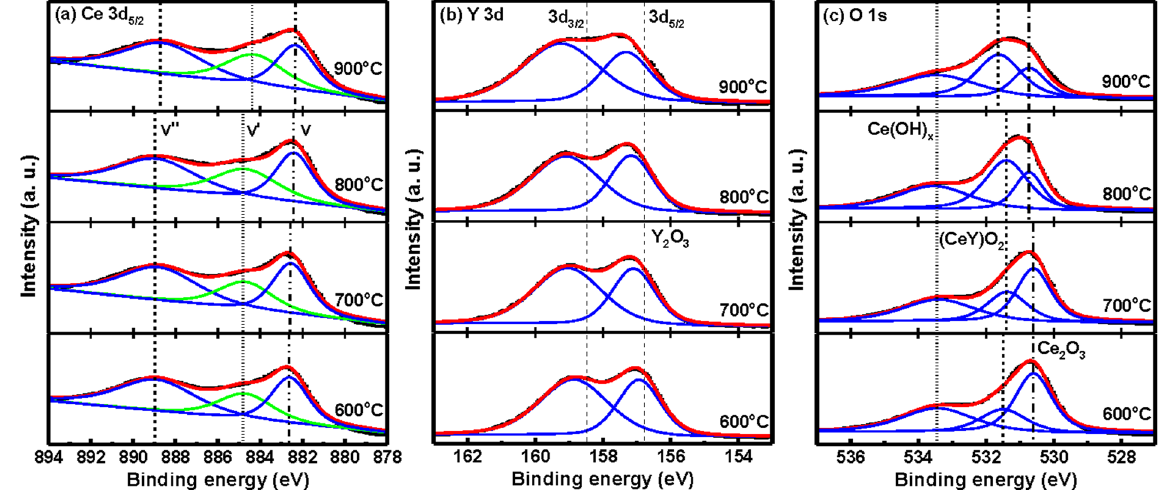
Figure 4. XPS spectra displaying the ( a ) Ce 3d, ( b ) Y 3d, and ( c ) O 1 s energy levels in CeY x O y films that had been annealed at various